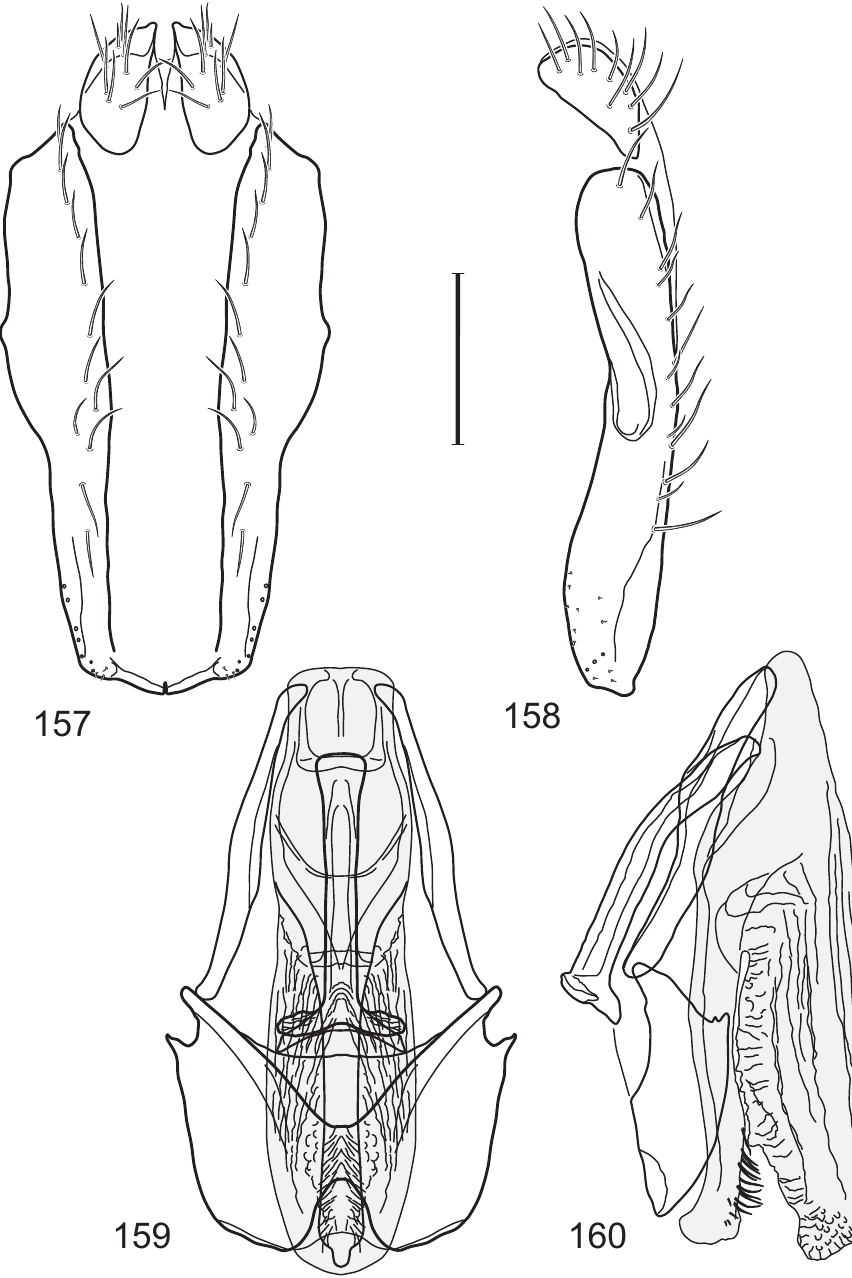
Figures 157–160. Hydrochasma capsum sp. n. (Puerto Rico. Rio Hoconuco) 157 epandrium and cerci, posterior view 158 same, lateral view 159 internal structures of male terminalia (aedeagus [shaded], phallapodeme, gonite, hypandrium), ventral view 160 same, lateral view. Scale bar = 0.1